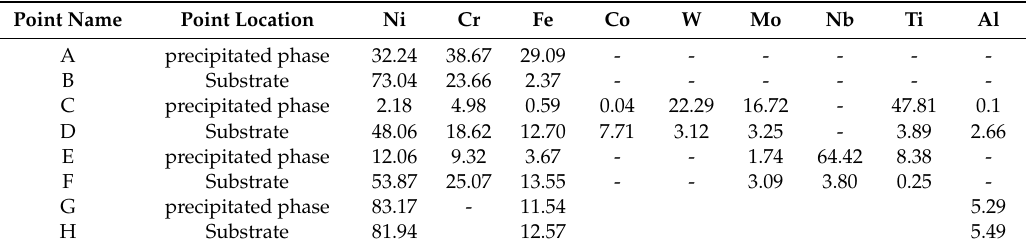
Table 4. Results of point measurement of EDS in four kinds of Ni-based cladding layers (wt.%).